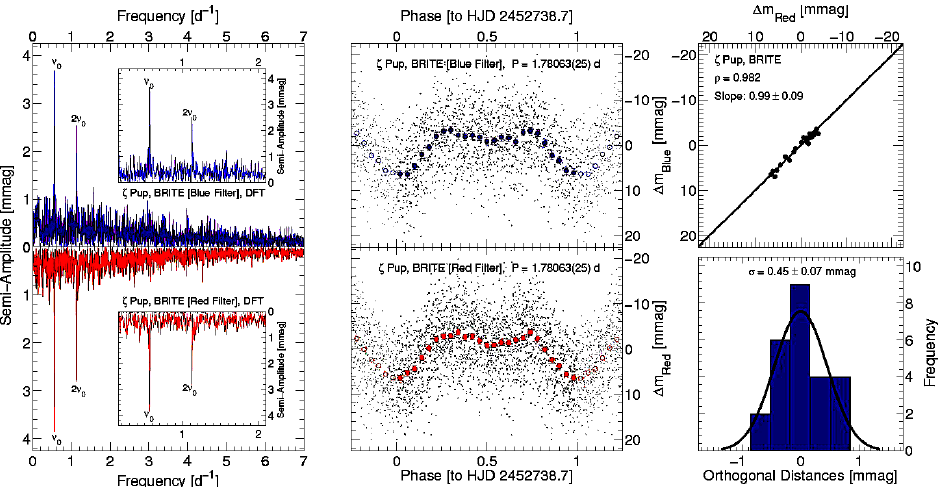
Figure 13. Left : Fourier transform of the red and blue 2014/15 BRITE photometry of ζ Puppis (see Figure10 for VelPup I-VI runs). Middle : Corresponding rotation light curve (P = 1.78d). Coloured points are 0.04 phase bins with 1 σ error. Note the large, real scatter, which could be due to stochasti- cally varying short-lived bright regions in the photosphere which lead to clumps in the wind. Right : Comparison diagram for the phased blue and red light curves ( top ), and distribution of orthogonal distances with a Gaussian fit ( bottom ). (Figure5 of Ramiaramanantsoa et al.